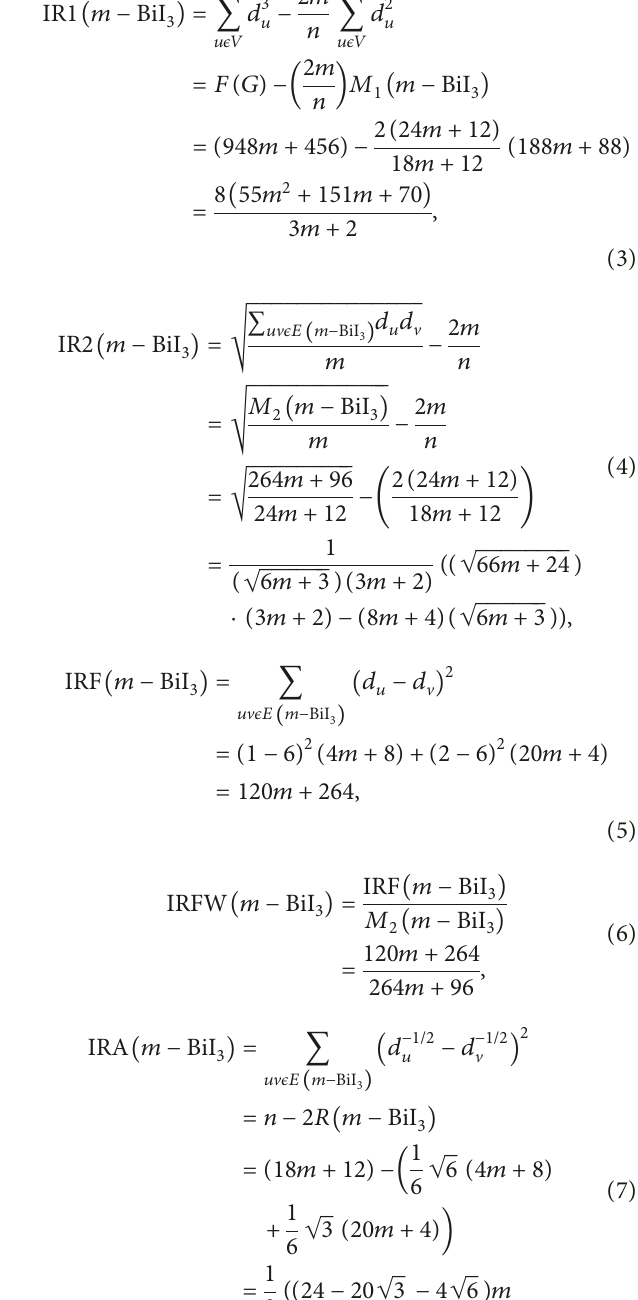
Table 1: Partition of E ( m − Bil